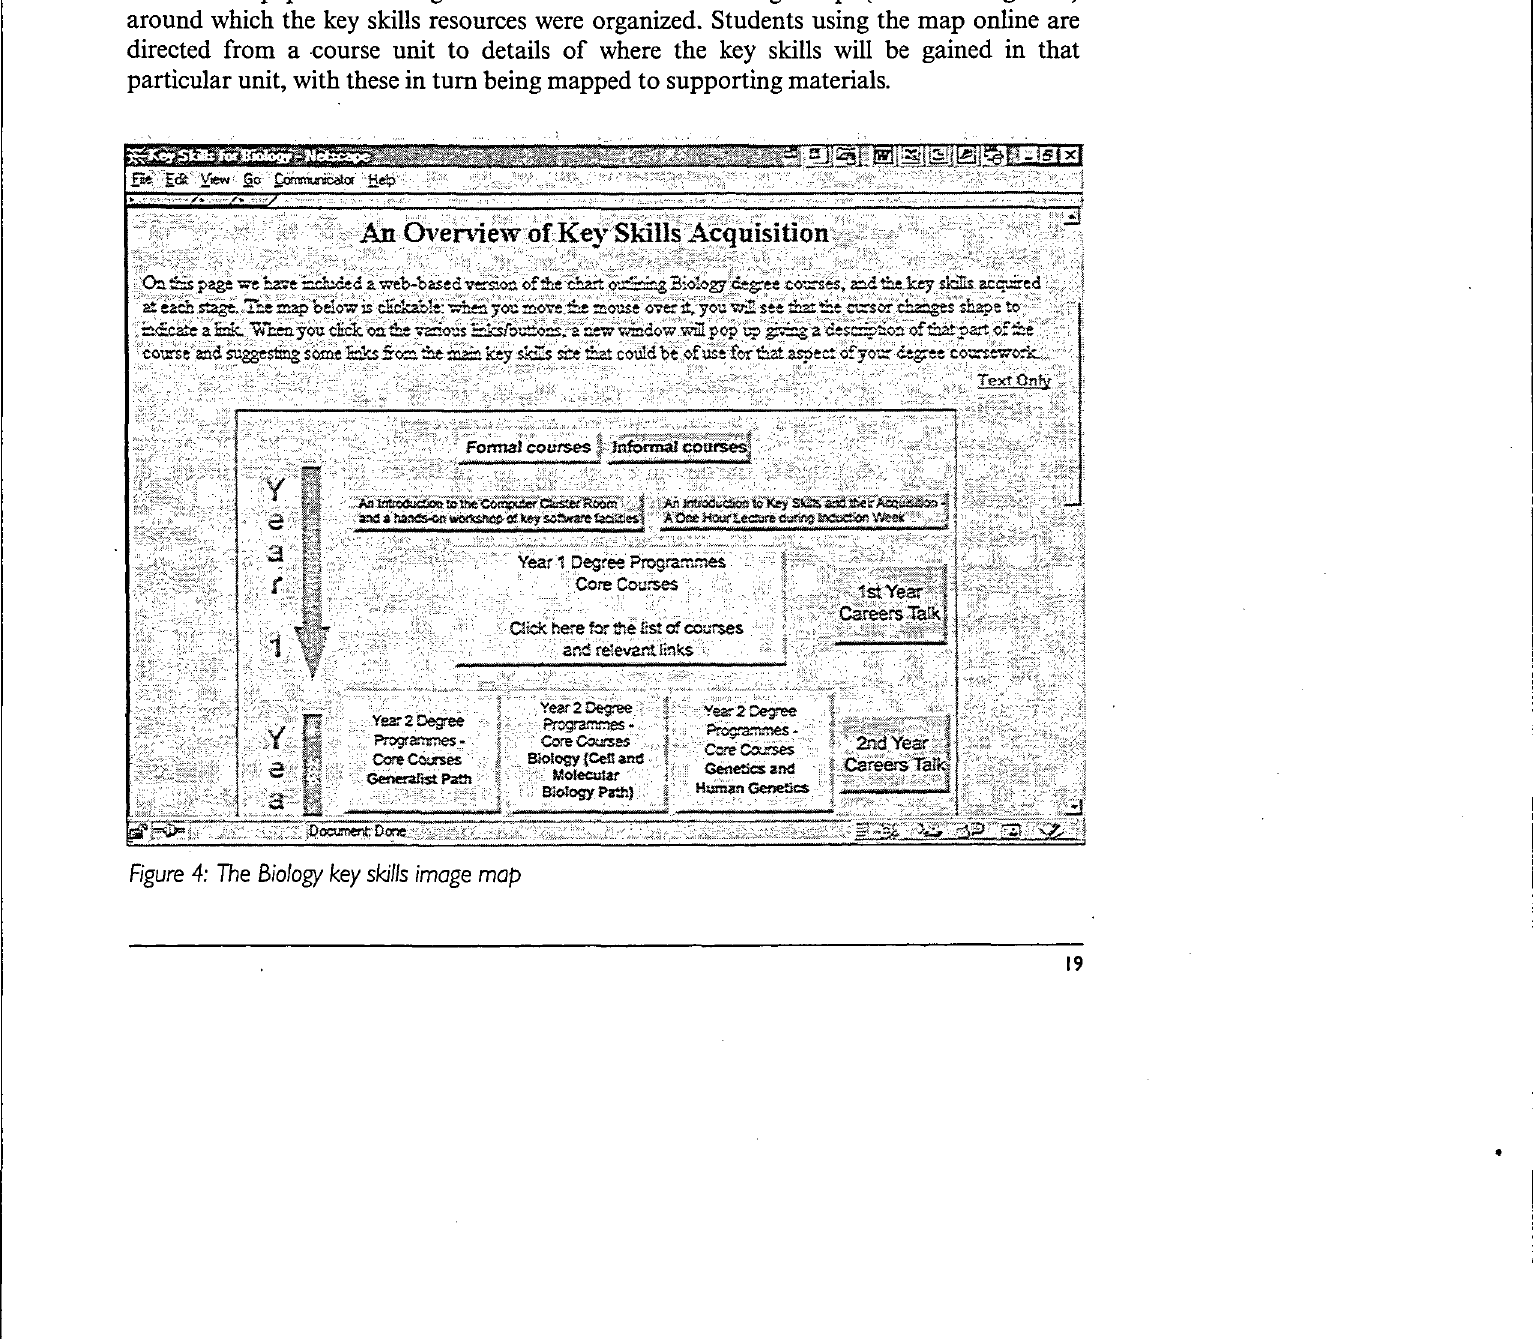
Figure 4: The Biology key skills image